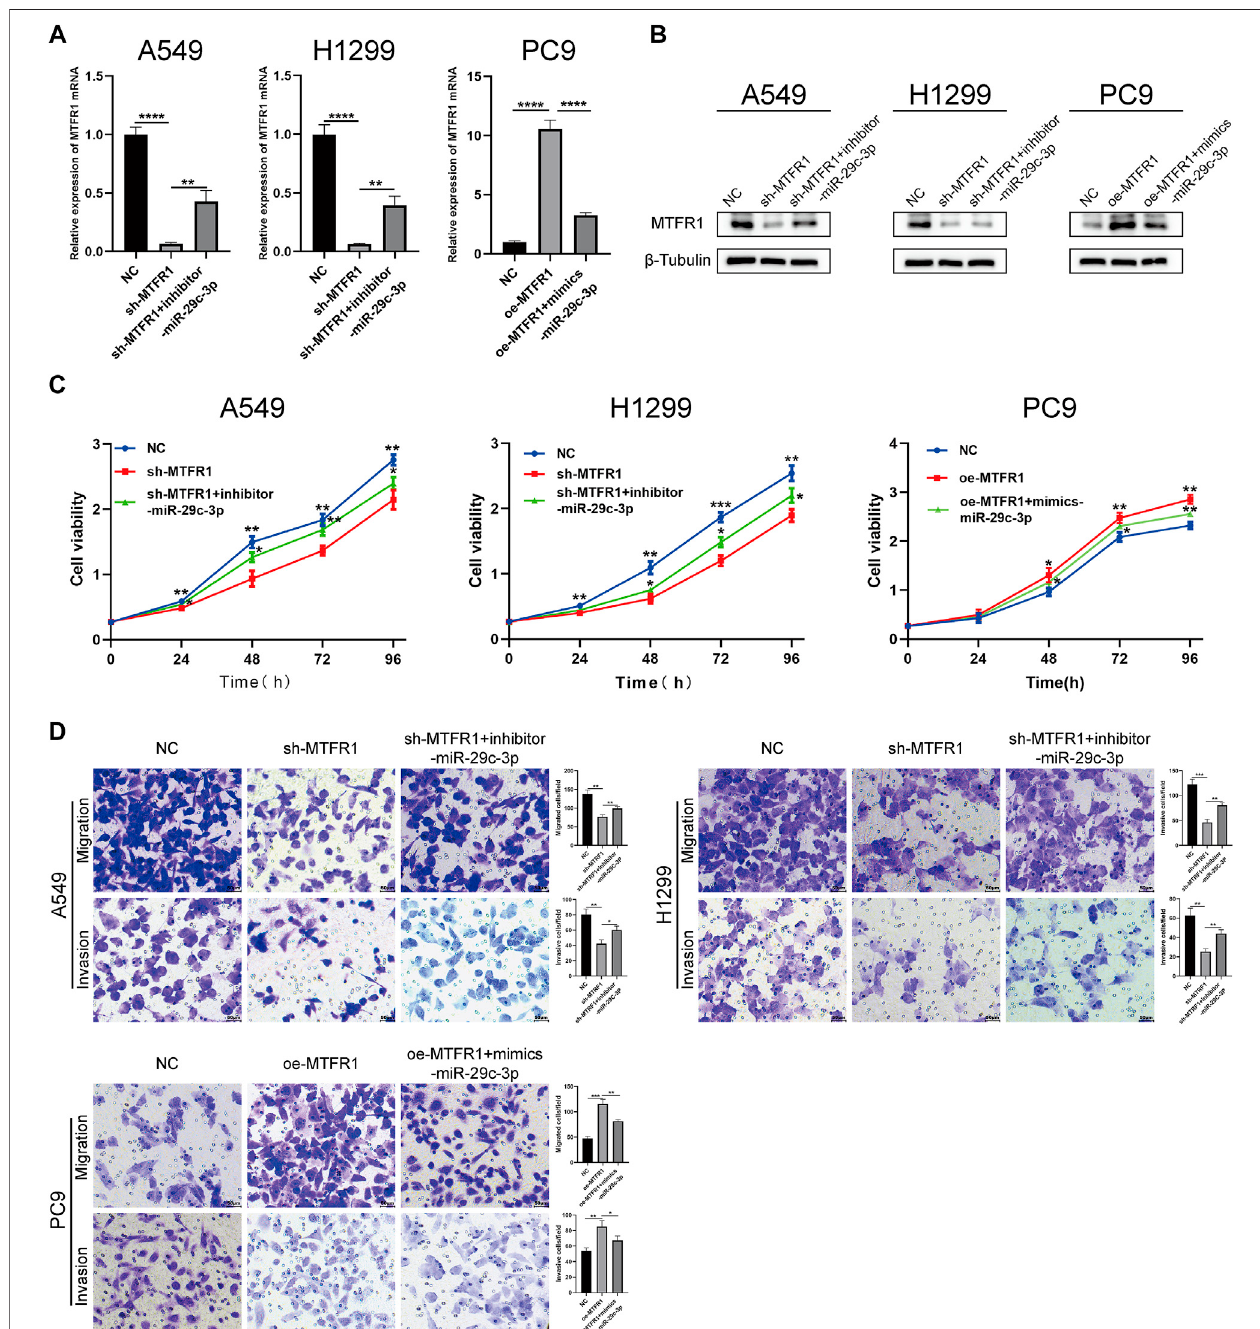
FIGURE 7 | miR-29c-3p could partly rescue the phenotypic changes caused by MTFR1. (A, B) Transfection ef fi cacy validated using real-time quantitative polymerase chain reaction (RT-qPCR) and WB. (C) miR-29c-3p could rescue the effect of MTFR1 on the proliferation of LUAD cells. (D) miR-29c-3p could rescue the effect of MTFR1 on the invasion and migration of LUAD cells. Data were articulated as the mean ± standard deviation (SD; * p < 0.05, ** p < 0.01, *** p < 0.001, **** p < 0.0001).